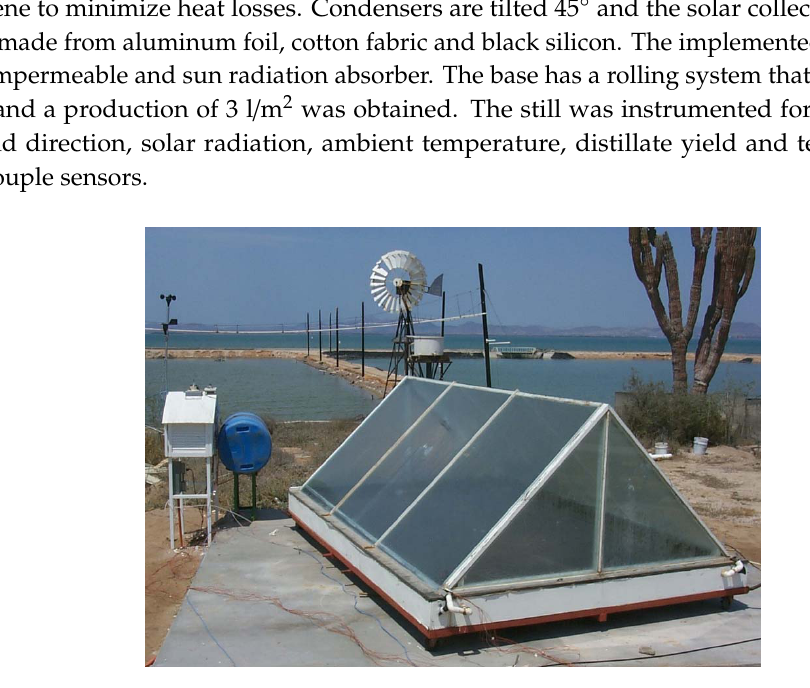
Figure 14. Orientation ‐ adjustable large cross ‐ section solar still for outdoor experimentation.